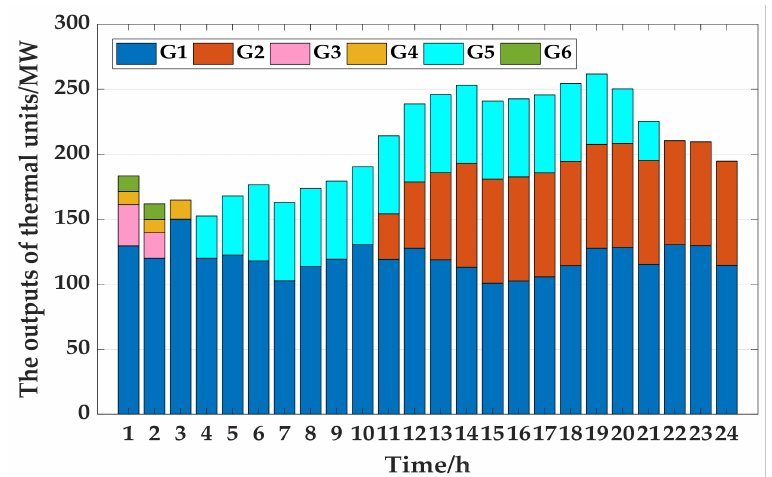
Figure 9. Outputs of thermal units at each period with DR participation in Case 3.